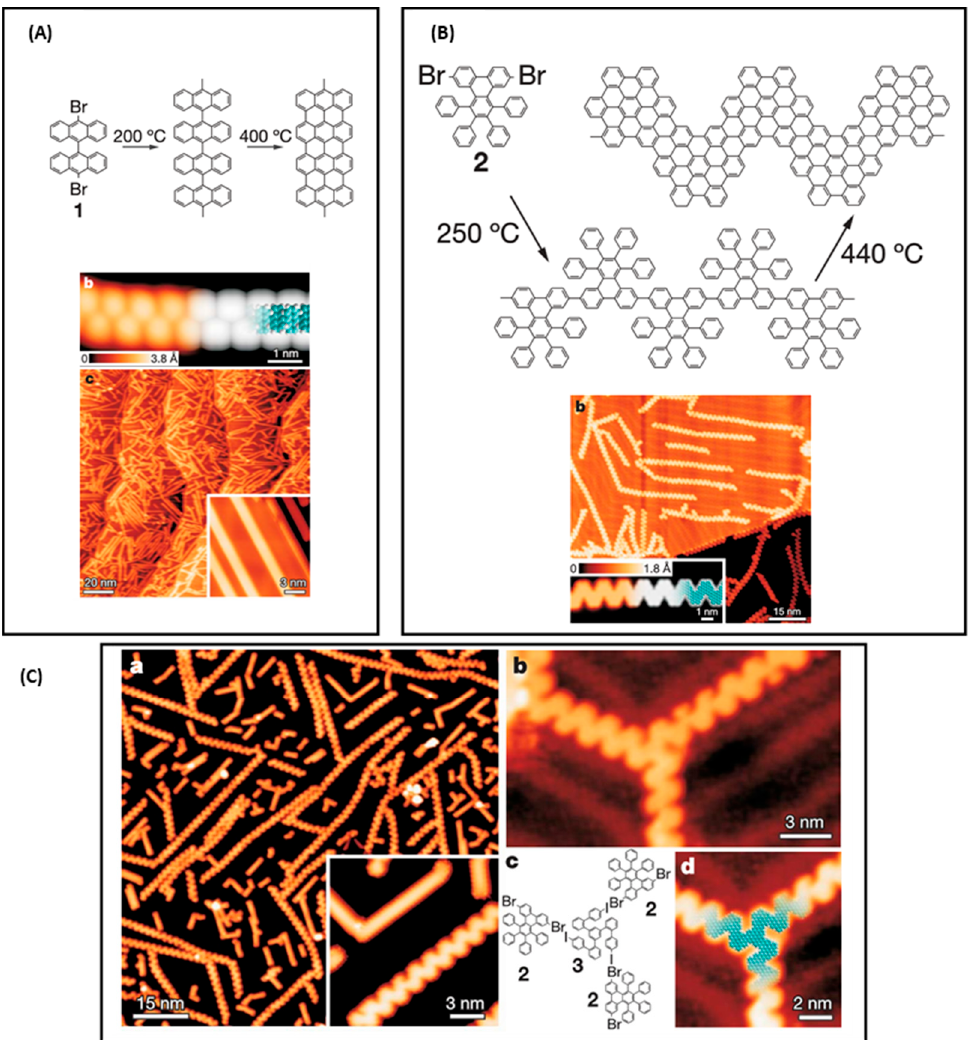
Figure 18. ( A ) Reaction mechanism and STM images of the formation of nanoribbons with 10,10’-dibromo-9,9’-bianthracene. ( B ) Reaction mechanism and STM images of the formation of zigzag nanoribbons with 6,11-dibromo-1,2,3,4-tetraphenyltriphenylene. ( C ) STM images of the copolymerization reaction. All experiments have been carried out on Au(111) surfaces. Reprinted by permission from Macmillan Publishers Ltd: Nature from [101], copyright 2010.